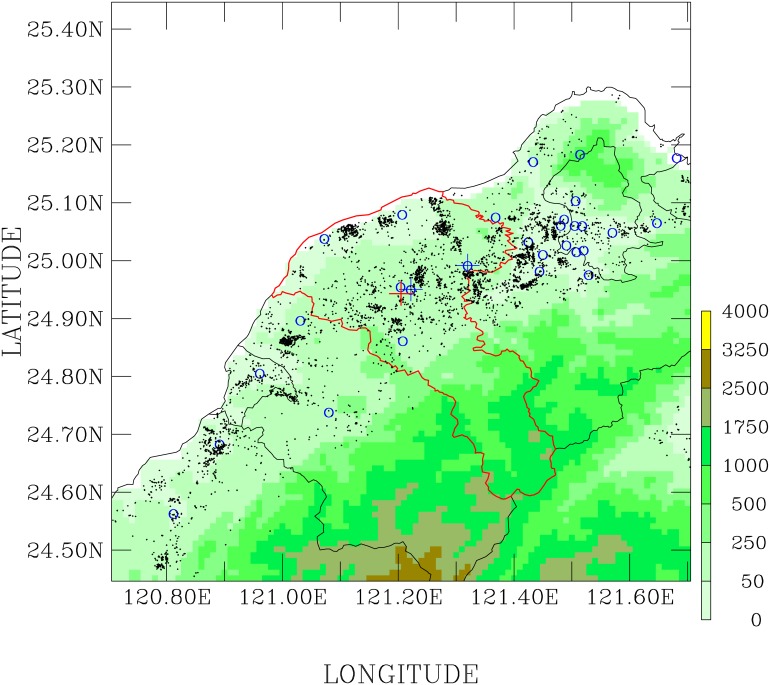
Spatial domain of Tao-Yuan City (marked by red colored curve), and terrain heights (shaded colors, in the unit of meters) distributed over northern Taiwan.Geographical locations of the Landseed Hospital (red corss); Chung-Li (a blue cross close to the red corss), Tao-Yuan (a blue cross on the right), and other ambient air monitoring stations (blue circles); and stationary air pollution sources (black crosses).